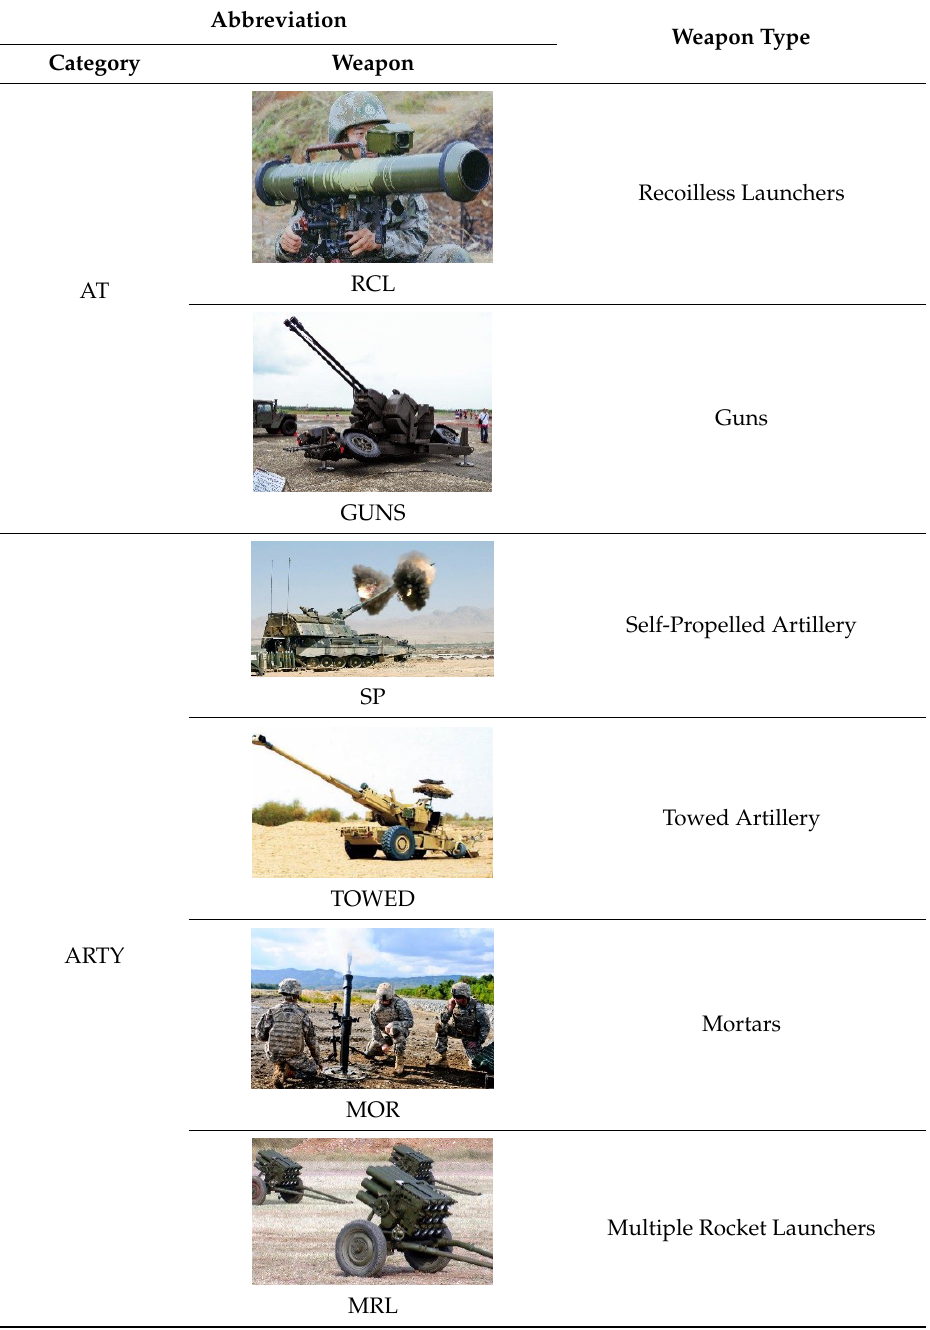
Figure 1. Map of